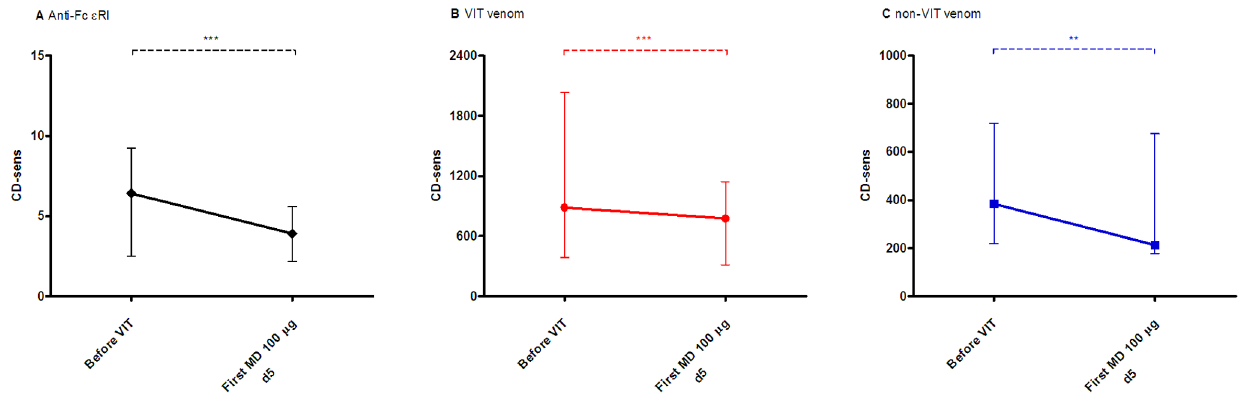
Figure 1. A–C. Basophil threshold sensitivity (CD-sens). Basophil threshold sensitivity (CD-sens) in 11 double and 7 single positive subjects in A to anti-Fc e RI and in B to VIT venom and in 11 double positive subjects in C to non-VIT venom stimulation before treatment and the first